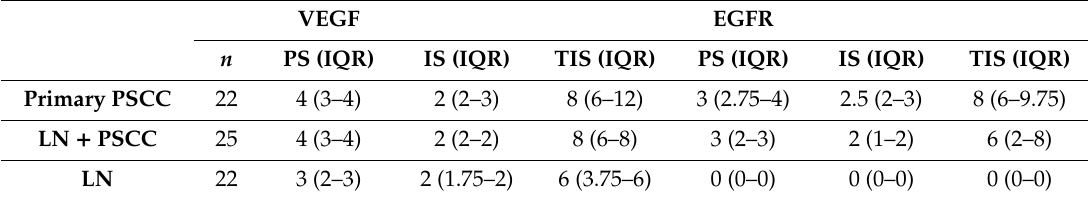
Table 1. Scoring immunoreactivity of vascular endothelial growth factor (VEGF) and epidermal growth factor receptor (EGFR) on penile squamous cell carcinoma (PSCC), median (interquartile range) .